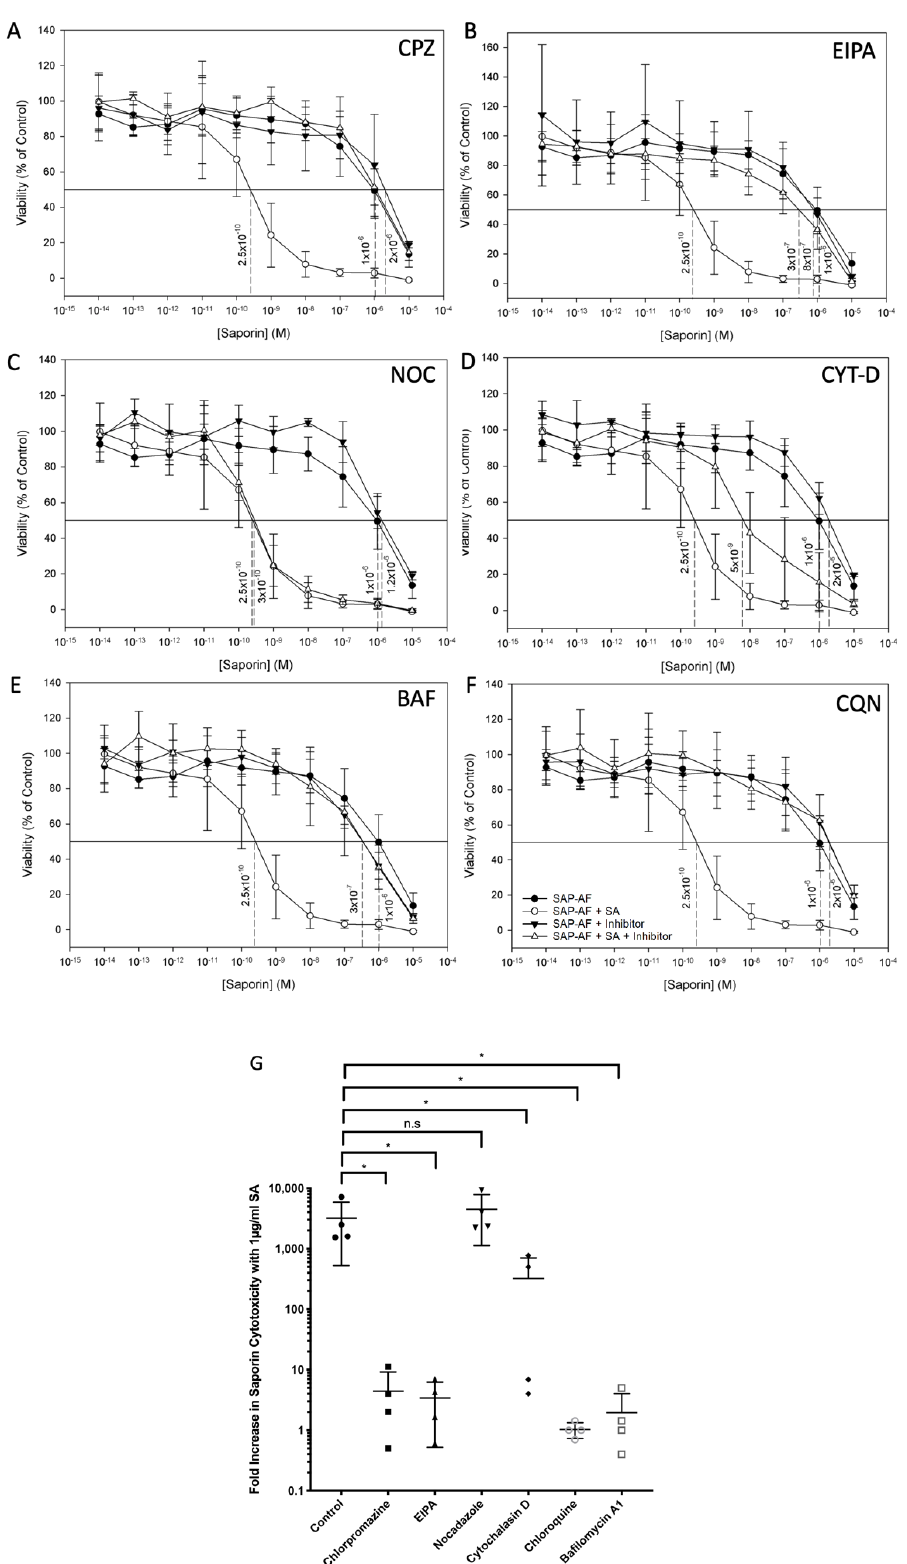
Figure 4. Inhibition of SA-mediated augmentation of saporin cytotoxicity in Daudi Cells by the various pharmacological agents studied. Effect of chlorpromazine ( A ), EIPA ( B ), nocodazole ( C ), cytochalasin D ( D ), bafilomycin A1 ( E ), and chloroquine ( F ) on the cytotoxicity of saporin and saporin used in combination with 1 µ g/mL of SA. ( A – F ):